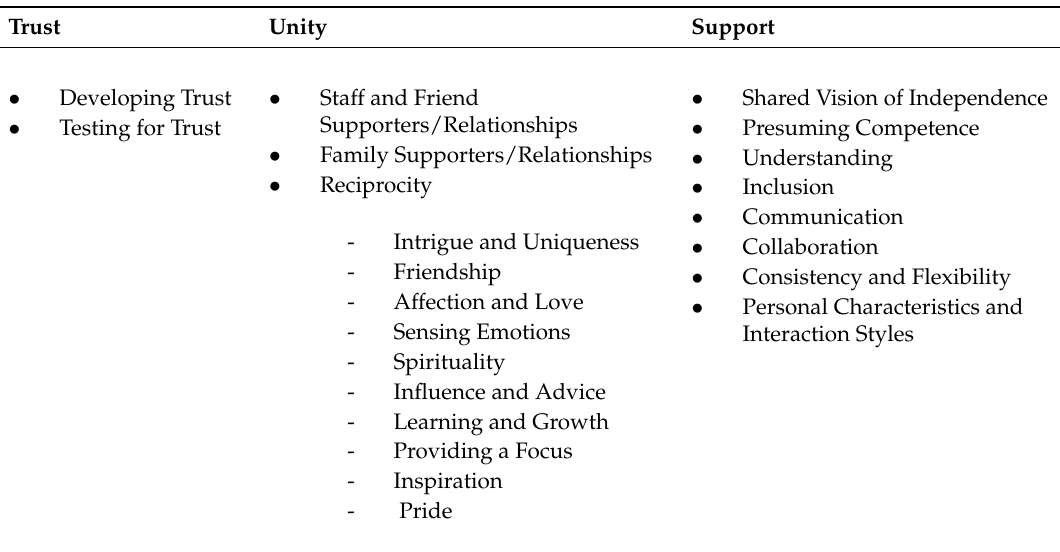
Table 5. Properties of Supportive